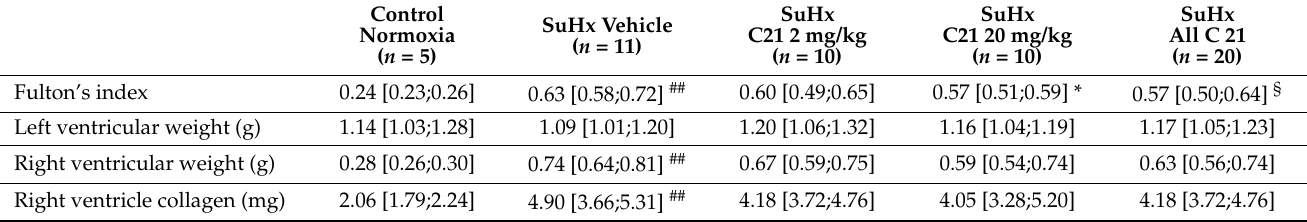
Table A4. Right ventricle